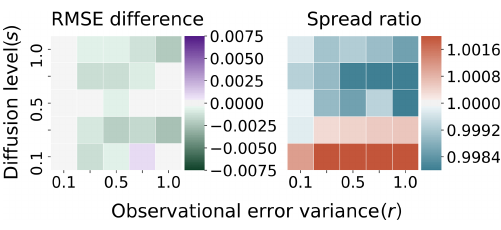
Figure 10. Truth: Taylor (cid:49) t = 5 × 10 − 3 . Ensemble: Euler– Maruyama (cid:49) e = 10 − 3 . Difference in RMSE/ratio of spread with benchmark Fig.